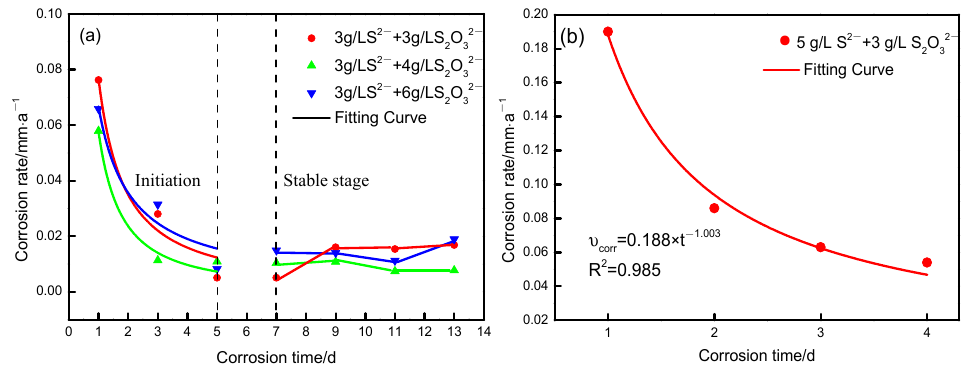
Figure 6. Corrosion rate of Q235 steels with different corrosion times. ( a ) 1–13d; ( b ) 1–4d